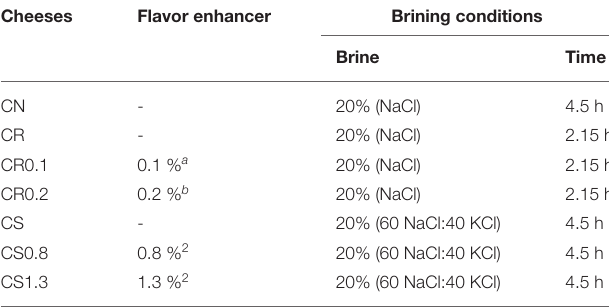
TABLE 1 | Denomination of cheeses. Cheeses Flavor enhancer Brining